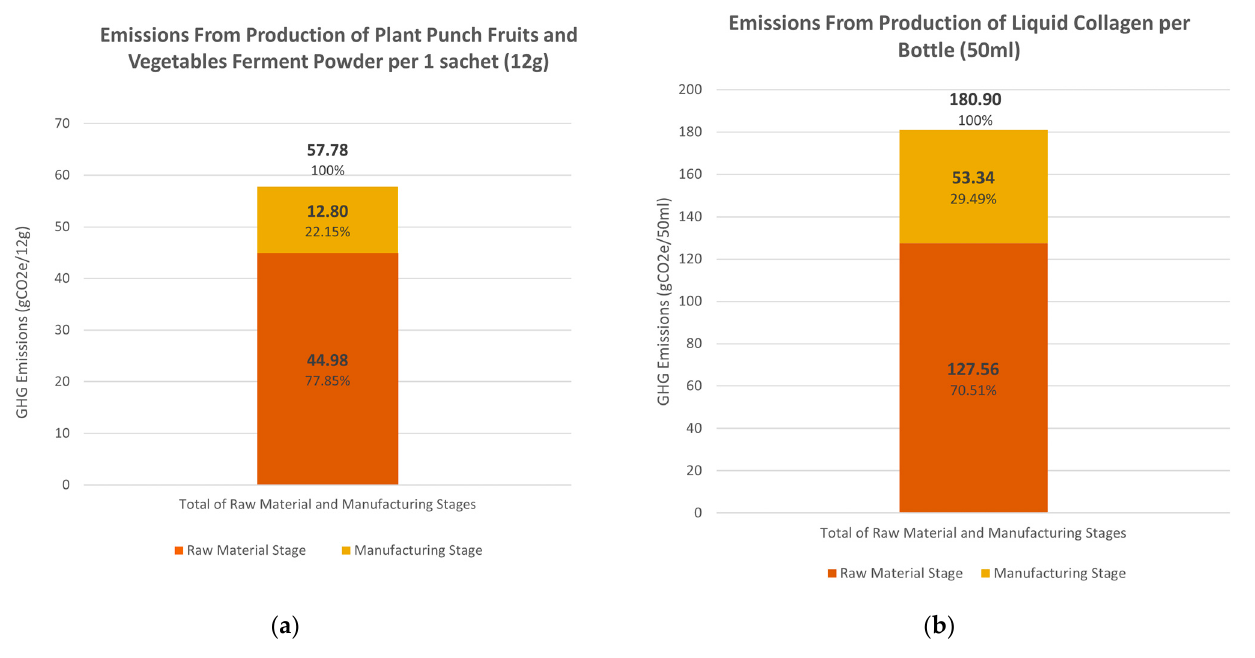
Figure 2. GHG Emissions (g CO 2 e) of products at The Raw Material and Manufacturing Stages with Percentages of Total Emissions. ( a ) Emissions of Plant Punch Fruits and Vegetables Ferment Powder; and ( b ) Emissions of Liquid Collagen.